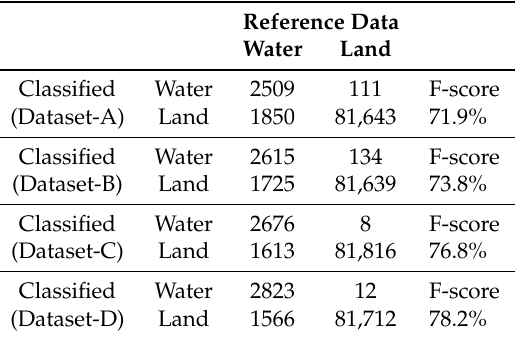
Table 4. Error matrices derived from images taken from 23 May